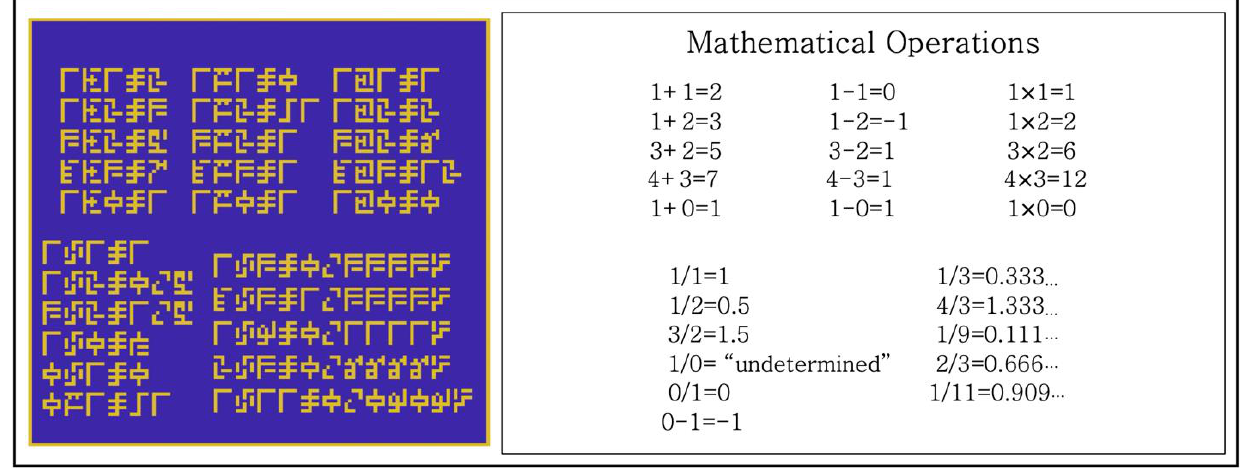
Figure 8. Pictural representation and explanation of the meaning in the Message, page 2.